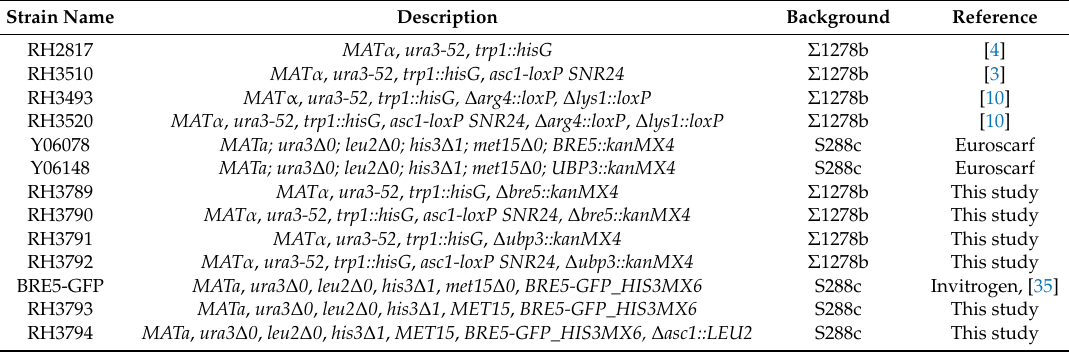
Table 2. Saccharomyces cerevisiae strains used in this